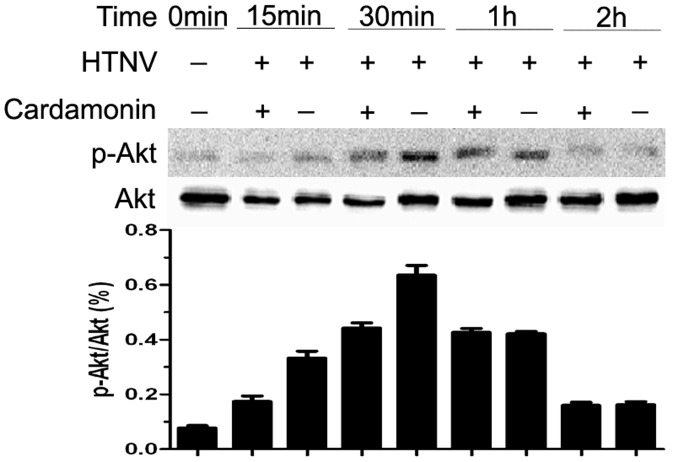
Effect of cardamonin on the HTNV-induced activation of Akt.The upper panel, HUVECs were pretreated for 30-Akt was detected by Western blot analysis as described before. The bottom panel represents Akt to show equal loading of cell lysates. Data are shown as the ratio of the gray scale for p-Akt and Akt.